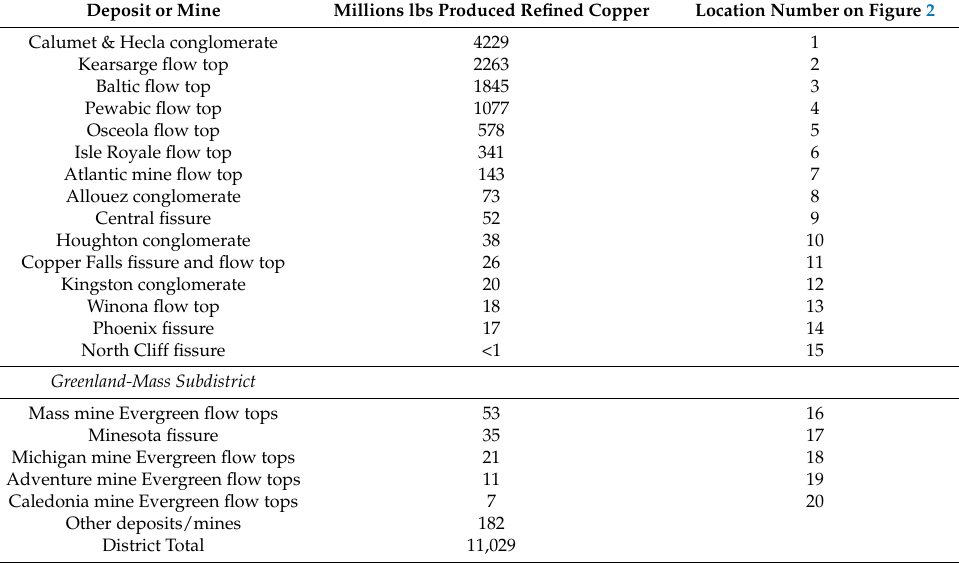
Table 1. Summary of copper produced from deposits/mines of the Keweenaw native copper district. Copper was exclusively as native copper; native silver occurs as a by-product of native copper mining but was not consistently recovered. The location of the deposits/mines is shown on Figure 2 and the copper isotope data are given in Table 2. Production figures are from Weege and Pollack [17] or Butler and Burbank